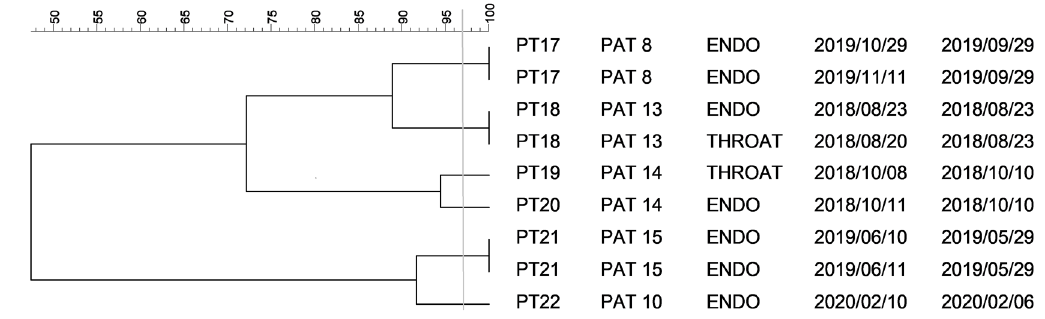
Figure 3. Dendrogram for restriction patterns of K. oxytoca isolates. Legend: horizontal axis—similarity of isolates (%); vertical axis—pulsotype, patient code, type of sample, date of sample collection, date of VAP diagnosis; PT pulsotype, PAT patient, ENDO endotracheal aspirate sample, THROAT throat swab. The vertical line indicates the similarity thresh- old set at 97%.